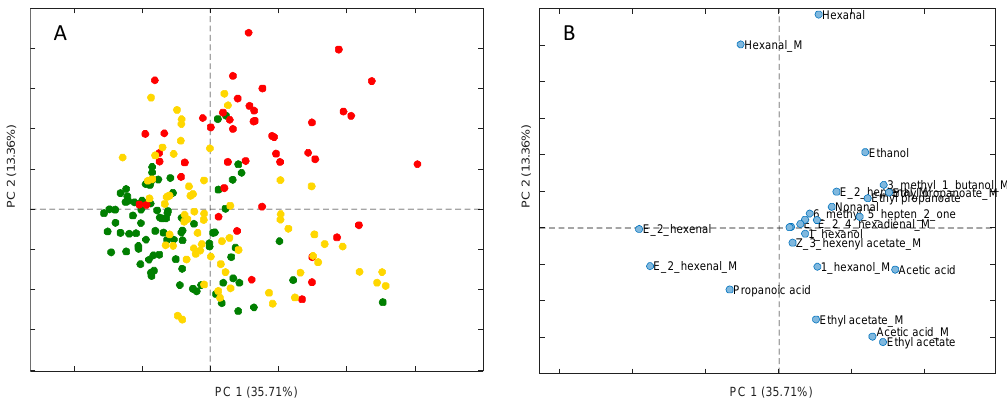
Figure 2. Score plot ( A ): green (EVOO), yellow (VOO), red (LOO); loading plot ( B ) obtained by principal component analysis (PCA).